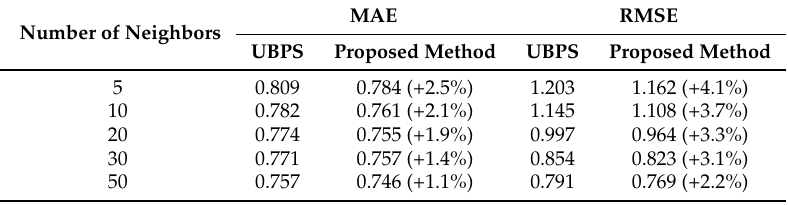
Table 3. Comparison between UBPS and proposed method with varying neighborhood